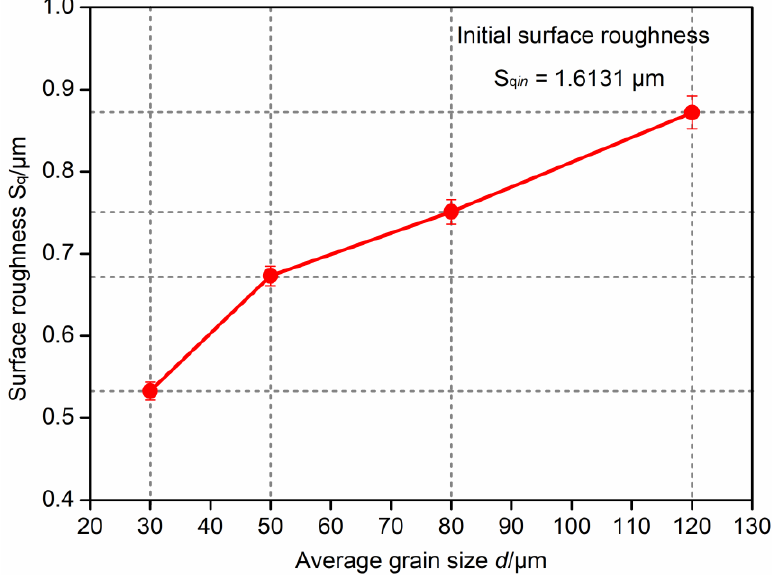
Figure 10. Change in specimen roughness under various grain sizes.